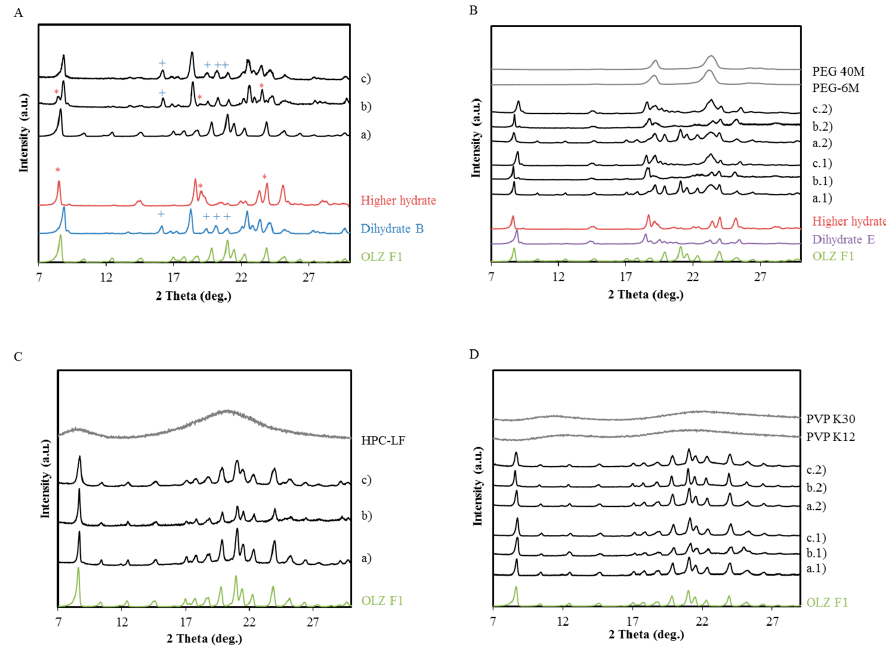
Figure 2. Diffractograms of six formulations before wetting, after wetting and after drying. The wet samples were analyzed after storage in a sealed container for 360 min. ( A ) OLZ before (a) and after wetting (b) and drying (c); (+) represents the characteristic peaks of the OLZ dihydrate B and (*) represents the characteristic peaks of the OLZ higher hydrate; ( B ) Formulations B1 and B2 physical mixture (a.1 and a.2), after wetting (b.1 and b.2) and after drying (c.1 and c.2); ( C ) Formulation C physical mixture (a), after wetting (b) and after drying (c); ( D ) Formulation D1 and D2 physical mixture (a.1 and a.2) after wetting (b.1 and b.2) and after drying (c.1 and c.2).